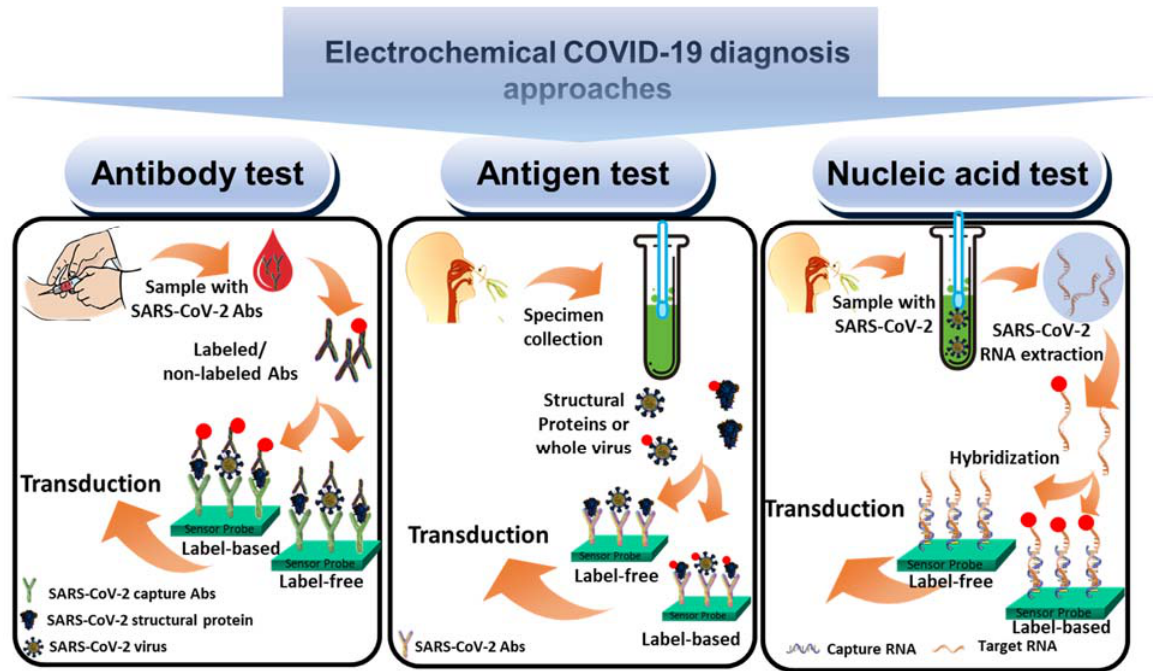
Figure 2. Schematic of the electrochemical strategies of COVID-19